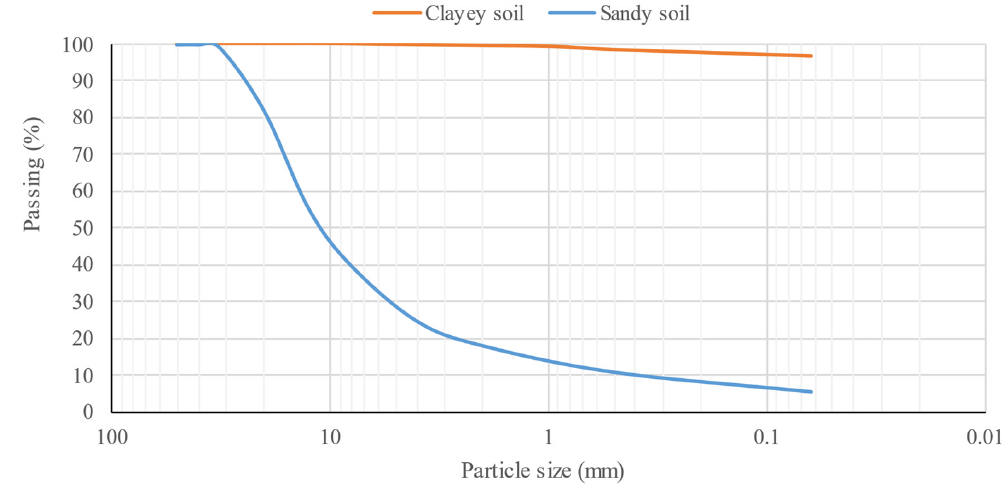
Figure 2. Particle size distribution of clayey soil and sandy soil.